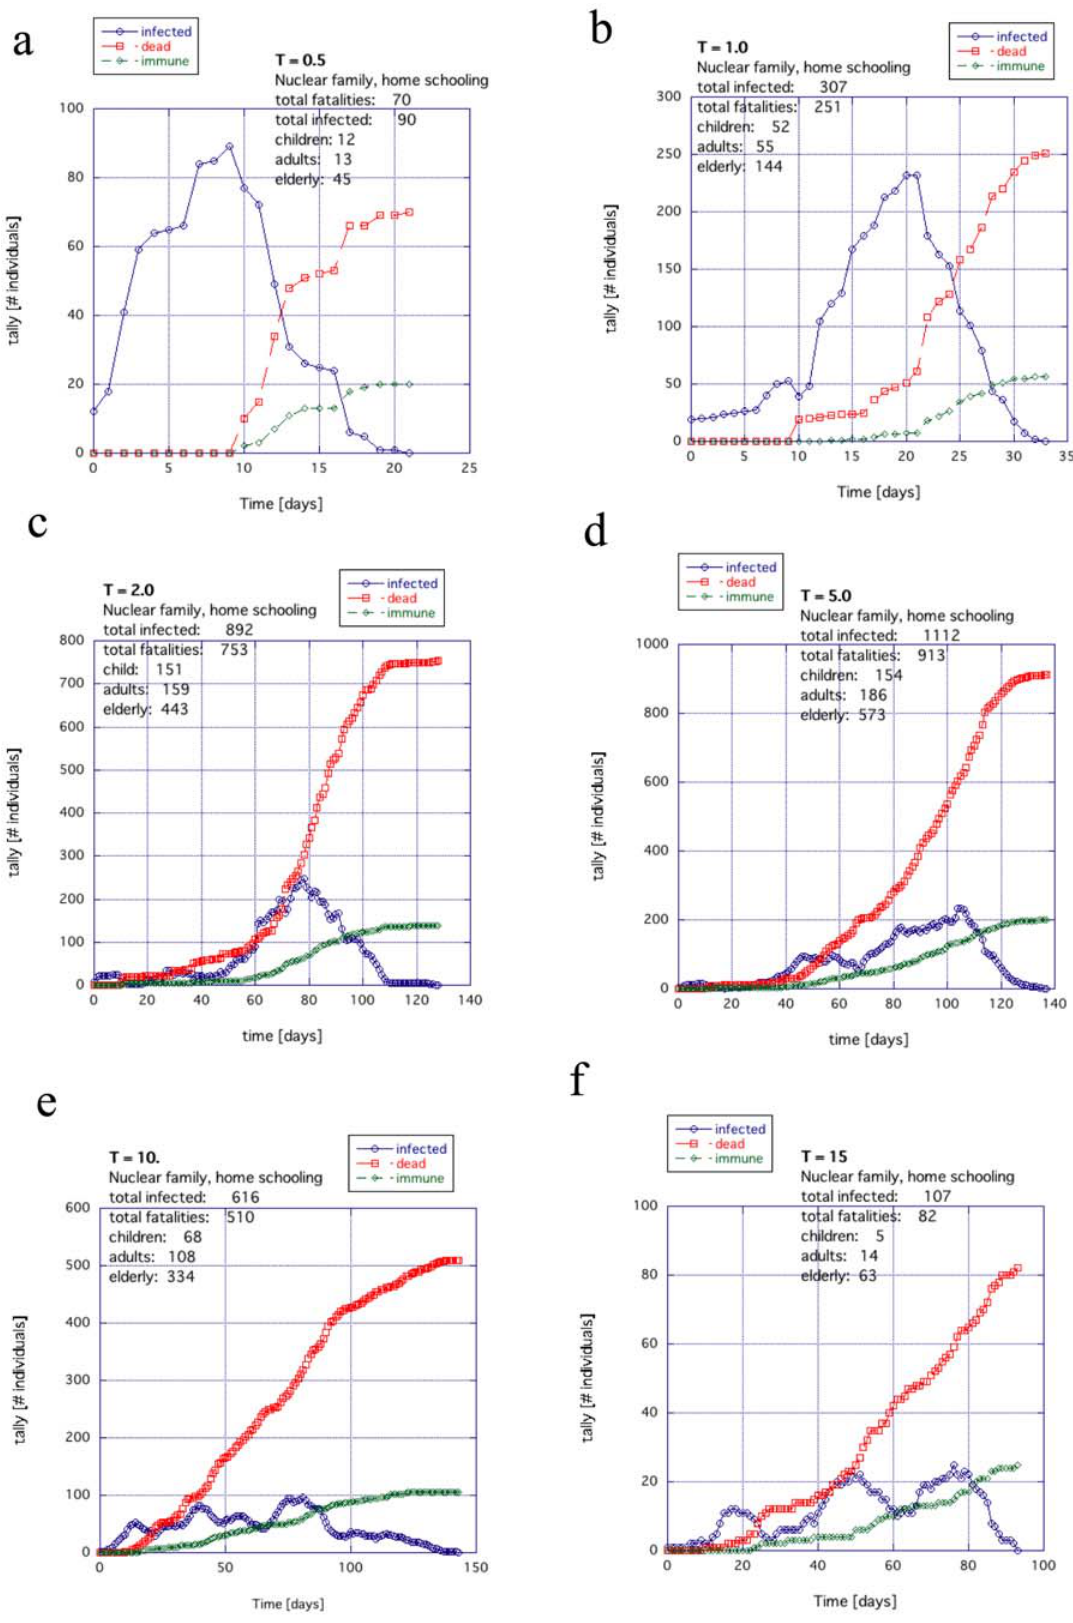
Figure 12. The general trend for temperature for the extended family example when the children are educated at home: (a) T ~ 1 , (b) 2.0, (c) 5.0, (d) 10.0 and (e and f) 15.0.